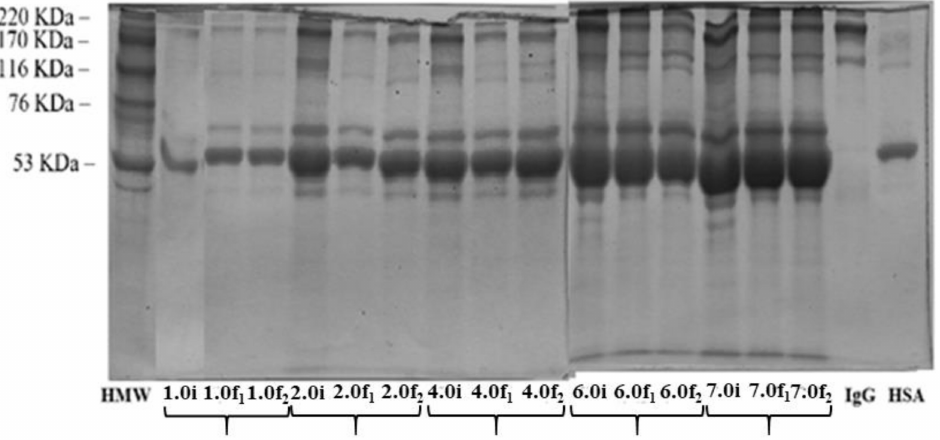
Figure 8. SDS–PAGE analysis of samples before and after adsorption batch experiments with human serum diluted in Tris/HCl at pH 9.0 revealing with Coomassie brilliant blue for all. HMW (molecular weight marker: Myosin (220 KDa), α -macroglobulin (170 KDa), β -Galactosidase (116 KDa), transferrin (76 KDa) e Lutamic Dehidrogenase (53 KDa)), X.0i (initial concentrations: 1.0, 2.0, 4.0, 6.0 and 7.0 mg mL − 1 ), X.0f (final concentrations: 1.0, 2.0, 4.0, 6.0 and 7.0 mg mL − 1 ), IgG (IgG standard), HSA (HSA standard). Each test was carried out in duplicated X.0f 1 and X.0f 2